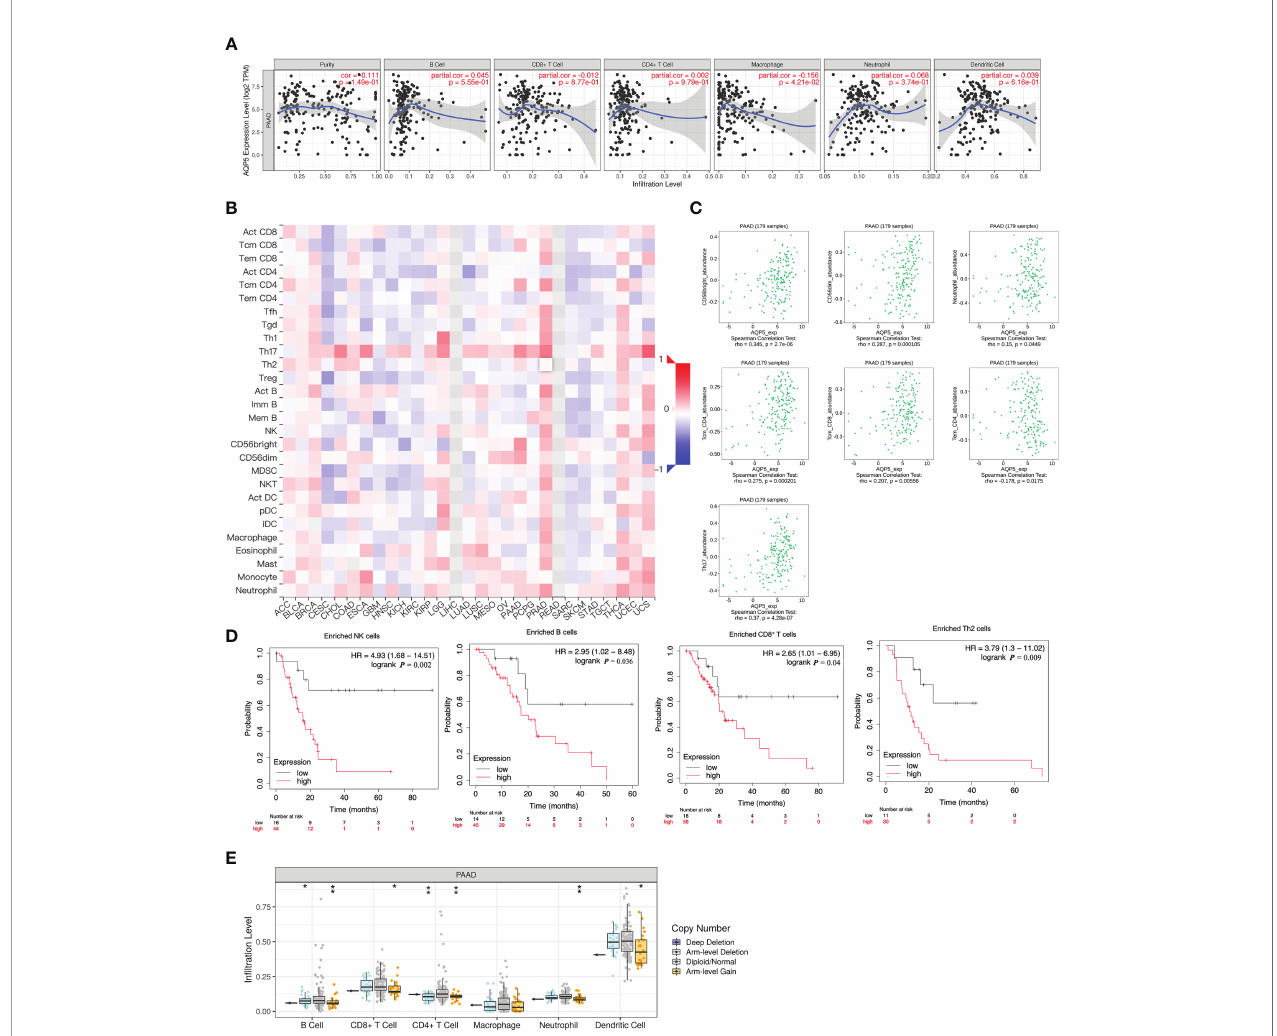
FIGURE 4 | Correlation between AQP5 expression and immune cell in fi ltrations in PAAD. (A) The expression of AQP5 in PAAD tissues positively correlated with tumor immune in fi ltration levels of macrophage. (B) Relationship between AQP5 expression and 28 subtypes of tumor-in fi ltrating immune cells in different kinds of tumors. (C) . The CD56 (bright) cell, CD56 (dim) cell, neutrophil, CD4 + central memory T cell, CD8 + central memory T cell, CD4 + effective memory T cell, and T helper cell 17 had signi fi cant Spearman ’ s correlation with AQP5 expression in PAAD. (D) Low AQP5 expression levels in PAAD in enriched B cell, natural killer cell, CD8 + T cell, and Th2 cell cohorts had a favorable prognosis. (E) The abundance of tumor-in fi ltrating immune cells with different somatic copy number aberrations of AQP5 in PAAD, * p < 0.05, ** p <